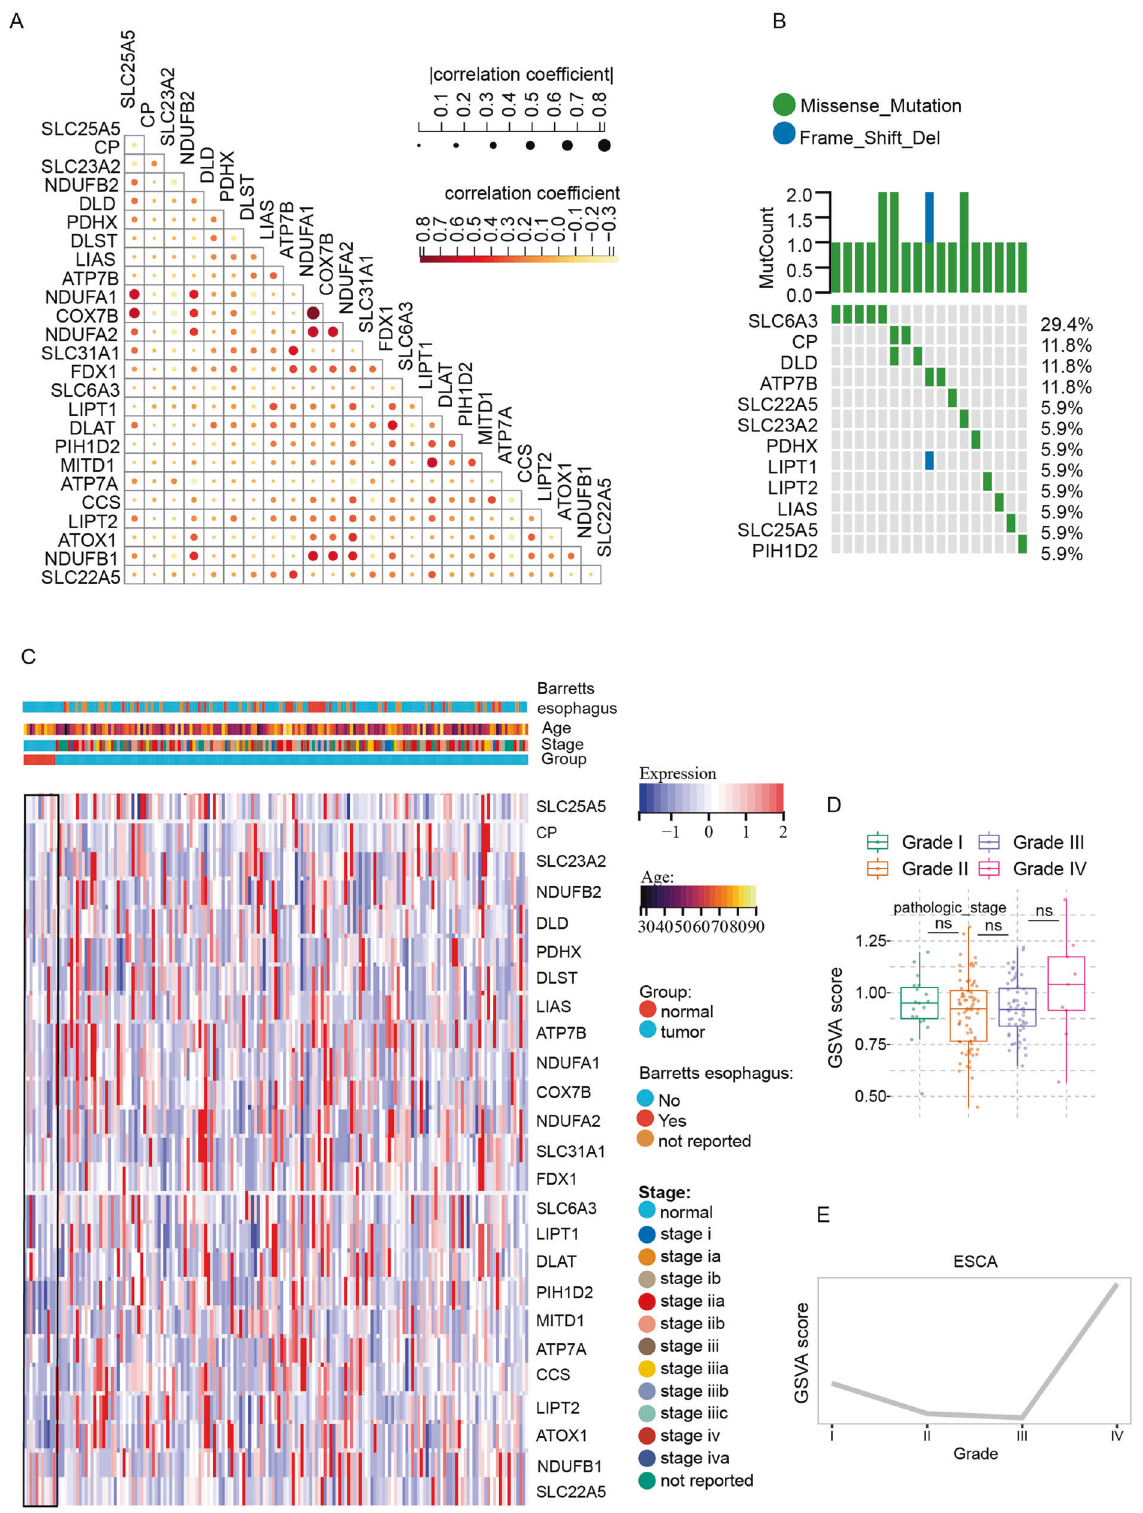
Fig. 1 The transcriptional and genetic alterations of cuproptosis-related genes in esophagus carcinoma. A The correlations between the expression of cuproptosis-related genes (CRGs). B Mutation frequencies of 25 CRGs in 173 patients with esophagus carcinoma (ESCA). C The heatmap showed the expression level and clinicopathologic features of 25 cuproptosis-related genes between normal and ESCA samples. D , E Differences ( D ) and tendency ( E ) in GSVA score of 25 CRGs in ESCA samples with different pathology grades. Data was exhibited as mean ± SD. Signi fi cance was assessed by Pearson ’ s correlation test ( A ), and KruskalWallis test ( D ). ns = not signi fi cant, * P < 0.05; ** P < 0.01; *** P < 0.001.